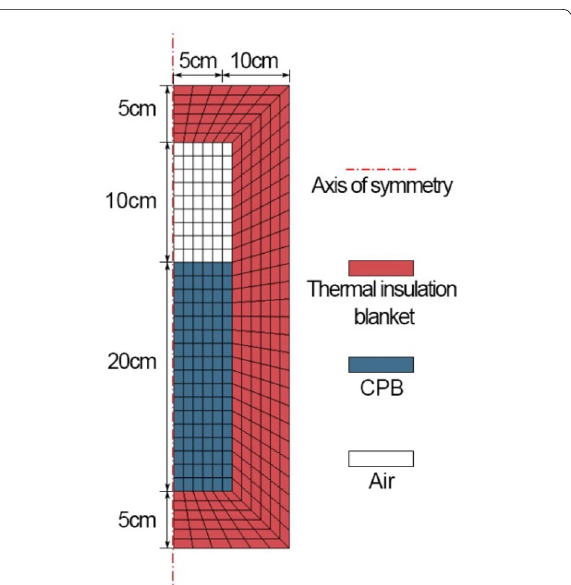
Fig. 2 Geometry and mesh of simulated model of cell test